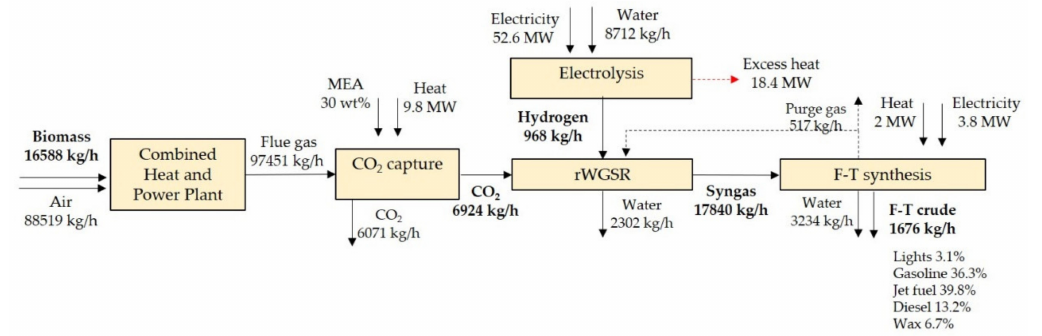
Figure 2. Block flow diagram for the production of BEJF from renewable feedstocks. Material flows of key streams are shown, and the composition of product stream is given in mass%. (rWGSR, reverse water–gas shift reactor; F–T,